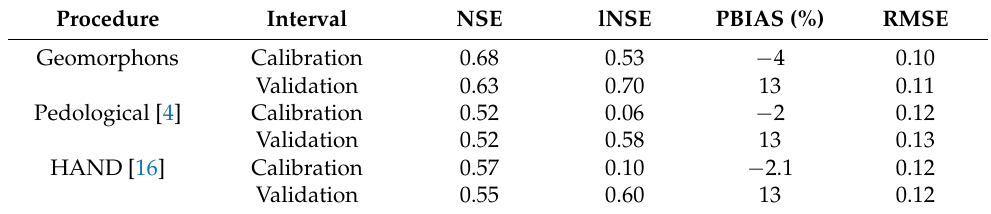
Table 4. DHSVM performance during calibration and validation by different input soil